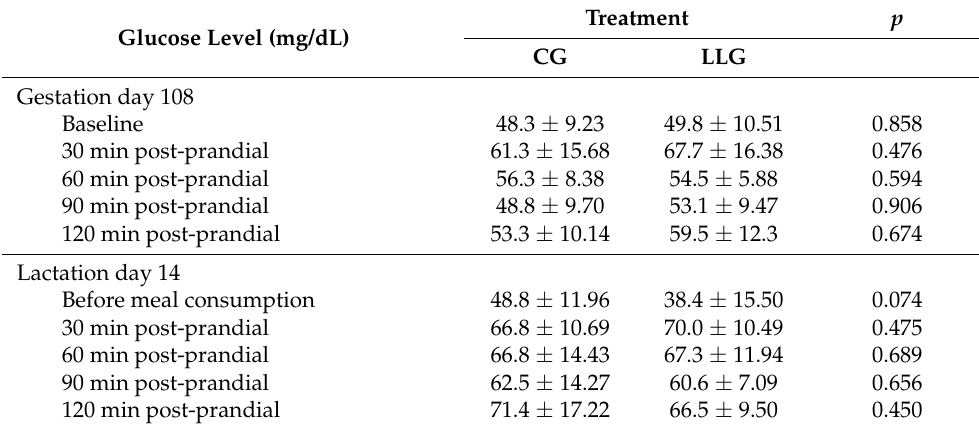
Table 4. Average blood glucose levels of sows before and 30, 60, 90 and 120 minutes after the consumption of morning meal according to treatment ( n = 15 per treatment).